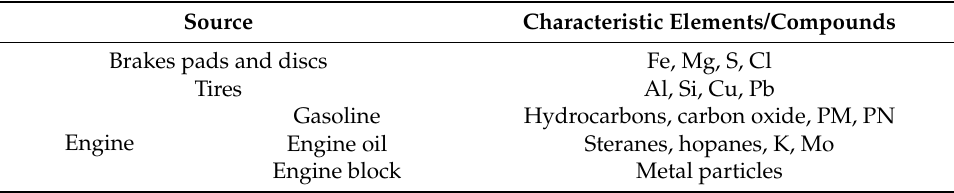
Table 2. Characteristic chemical compounds and their source.